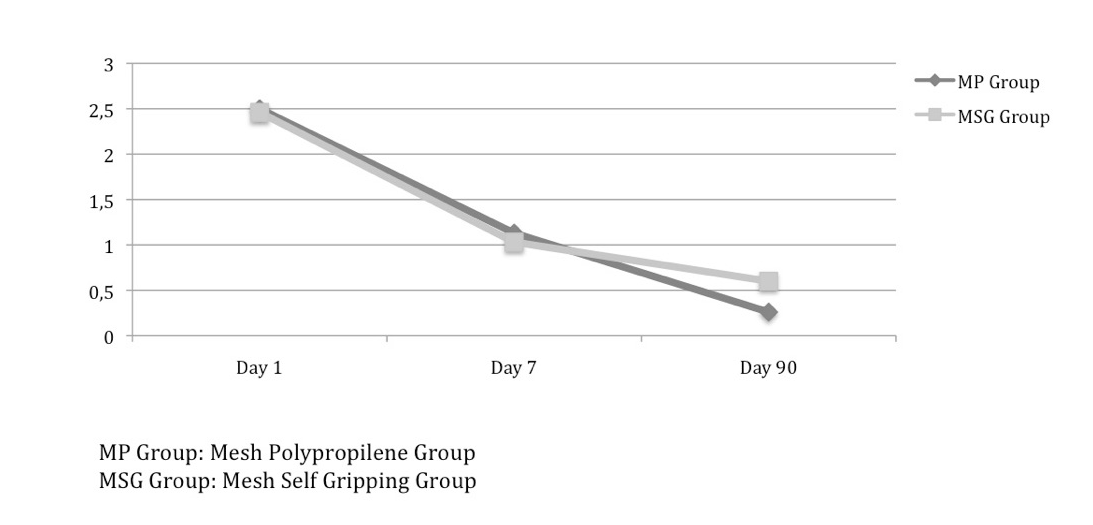
Figure 2: VAS Scale